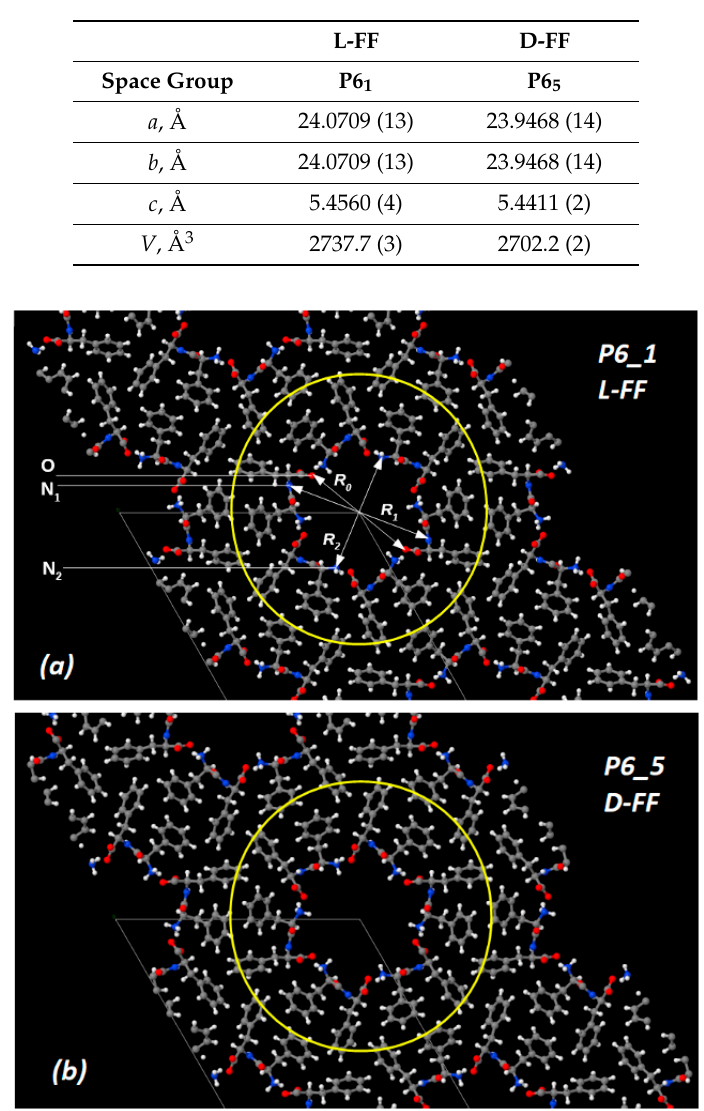
Figure 1. Images of structures based on the Cambridge Crystallographic Data Center (CCDC) for two different diphenylalanine (FF) enantiomers with symmetry elements (obtained using Jmol after performing Vienna Ab initio Simulation Package (VASP) calculations) for cases: ( a ) L-chiral (L-FF) with space group P6 1 and ( b ) D-chiral (D-FF) with space groups P6 5 . Hexagonal cells are marked by thin lines. Selected atoms and molecules for the formation of peptide nanotubes (PNTs) are shown by a circle in yellow lines. Atoms are marked with colors: oxygen—red, nitrogen—blue, carbon—gray, hydrogen—white. The upper figure ( a ) shows the distances in the inner cavity: R 0 —between the oxygen atoms O ... O; R 1 —between the nitrogen atoms N 1 ...N 1 (larger “far” diameter PNT); R 2 —between the nitrogen atoms N 2 ...N 2 of the opposing NH 3 + groups (short “near” inner diameter